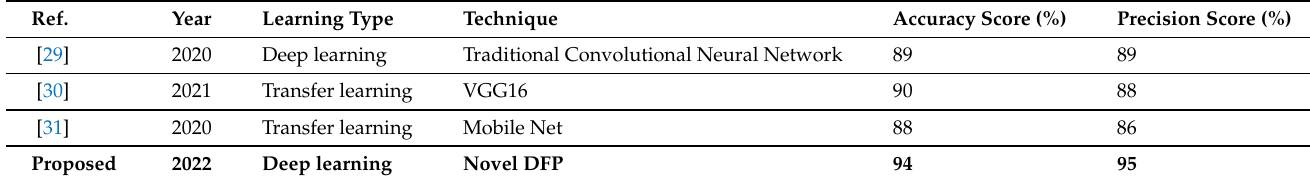
Table 10. The comparative performance analysis of the proposed approach with the other state of art